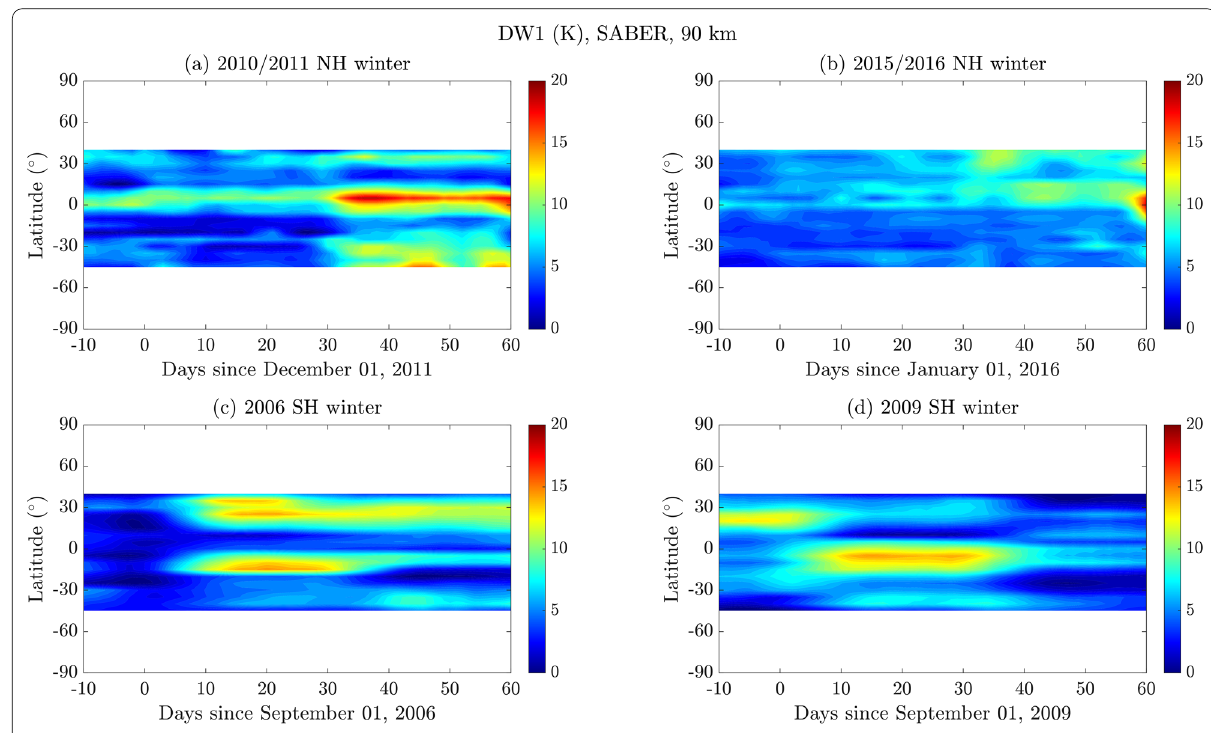
Fig. 5 Daily amplitudes of DW1 tide (K) in SABER temperature observations are presented in upper panels for (a) 2010/2011 and (b) 2015/2016 NH non-SSW winters. In the lower panels, the DW1 tidal amplitudes (K) are presented for (c) 2006 and (d) 2009 SH non-SSW